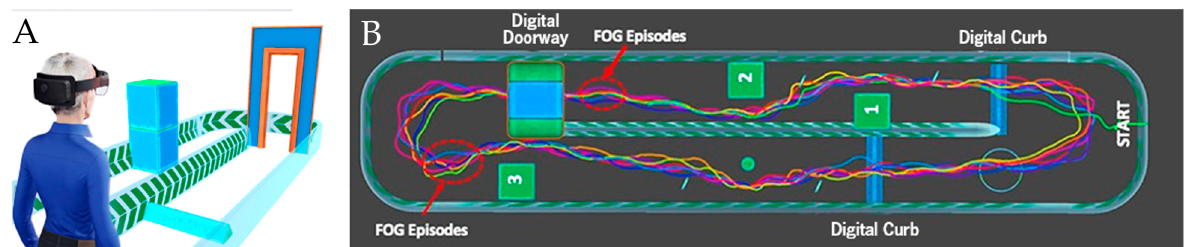
Figure of Eight: The participant completes repetitive left